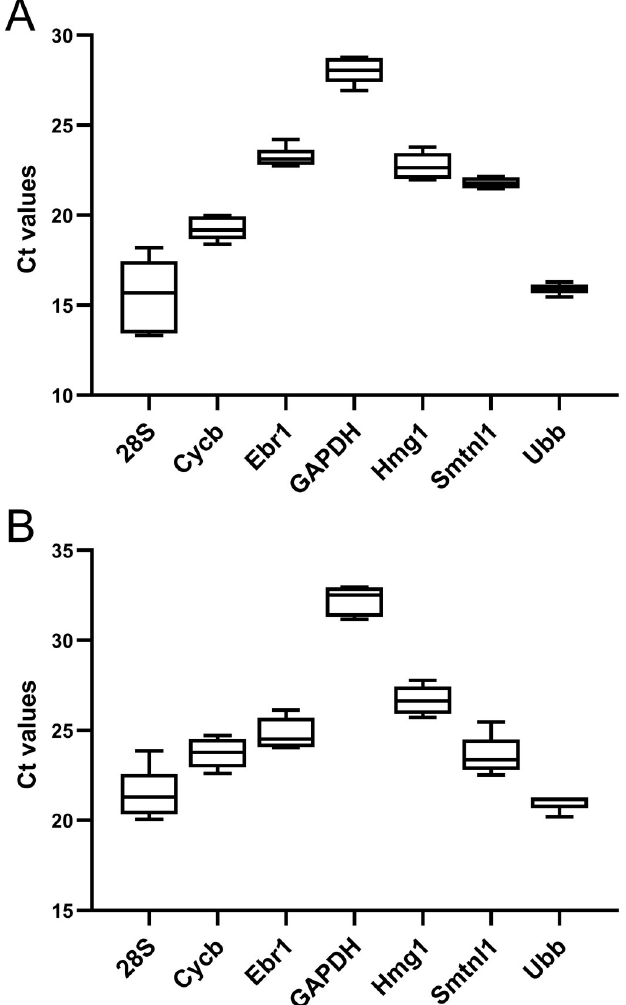
Fig 2. Boxplot of Ct values for candidate reference genes in all samples. (A) Ct values in cDNA samples synthesized from total RNA (B) Ct values in cDNA samples synthesized from mRNA. The boxes show interquartile range (25– 75%), horizontal lines represent medians. The whiskers show the minimum and maximum values. No outliers were